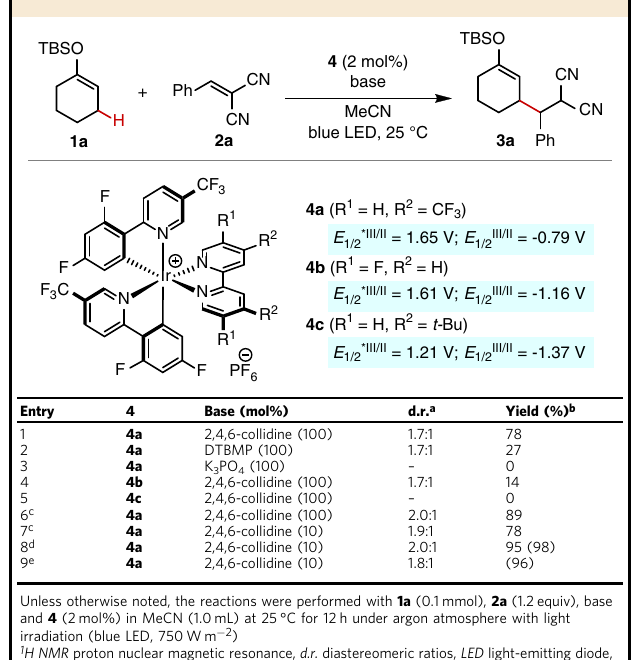
Table 1 Optimization of conditions for reaction of enol